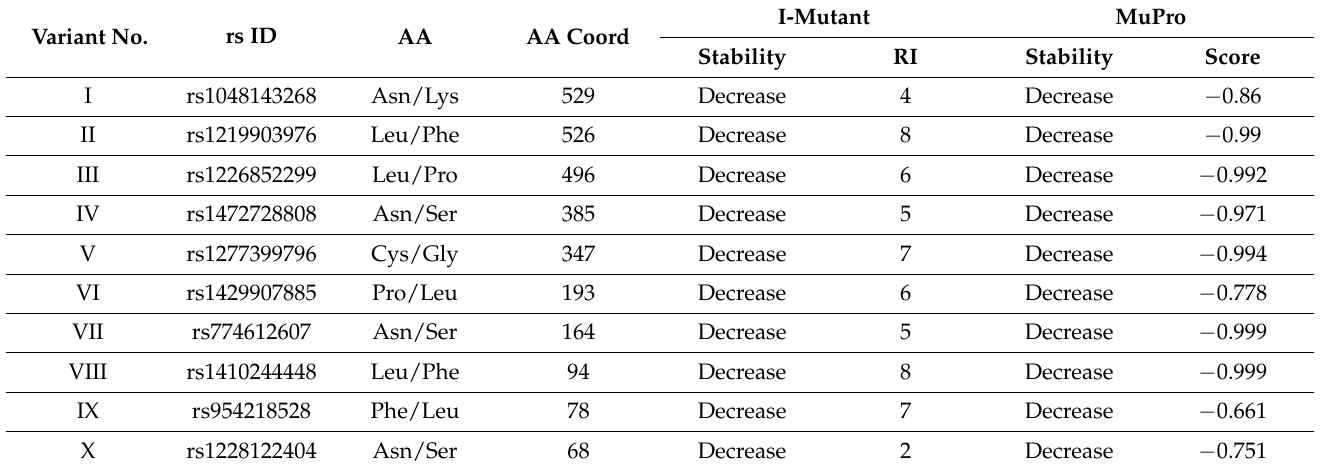
Table 2. List of variants showing decreases in the protein